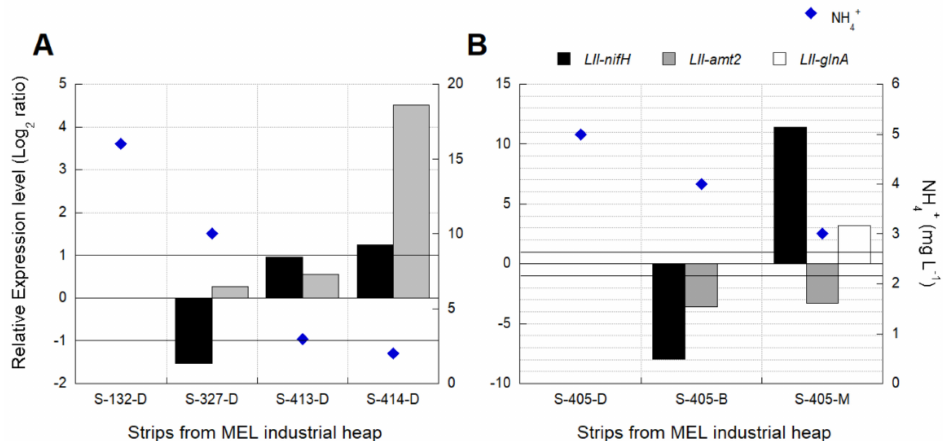
Figure 6. Transcriptional dynamics of nifH , amt2 , and glnA genes in L. ferriphilum (LII) from ( A ) strips S-132, S-327, S-413, S-414, and ( B ) S-405 of the MEL industrial copper bioleaching heap with different NH 4+ availabilities. D = Drop or base of the heap, B = the base of the second lift, M = the base of the fourth lift. Significant differences in relative expression were adjusted at − 1 < Log 2 ratio < 1 (horizontal black lines). Gene expression was calculated relative to the control samples (log 0 values) that correspond in ( A , B ), respectively, to S-132 and